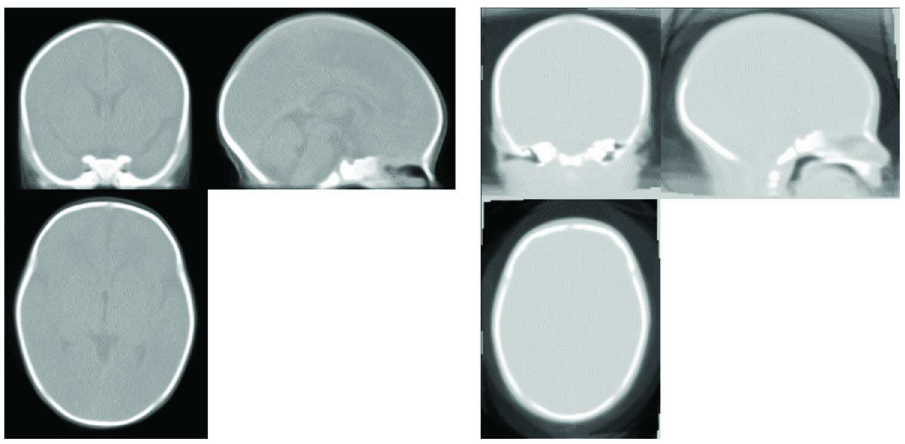
Fig 8. Qualitative comparison of the GRAMFC_CT 39-42 template (left) and the template proposed by Jafarian et al. [27] (right) for neonates with 39–42 weeks